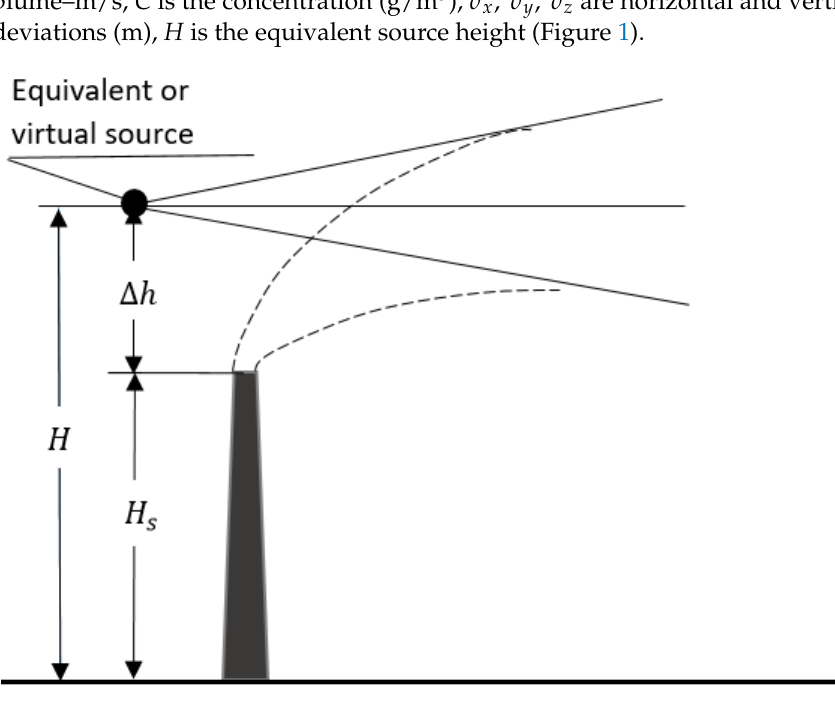
Figure 1. Schema of the pollutant dispersion from the pointed source.